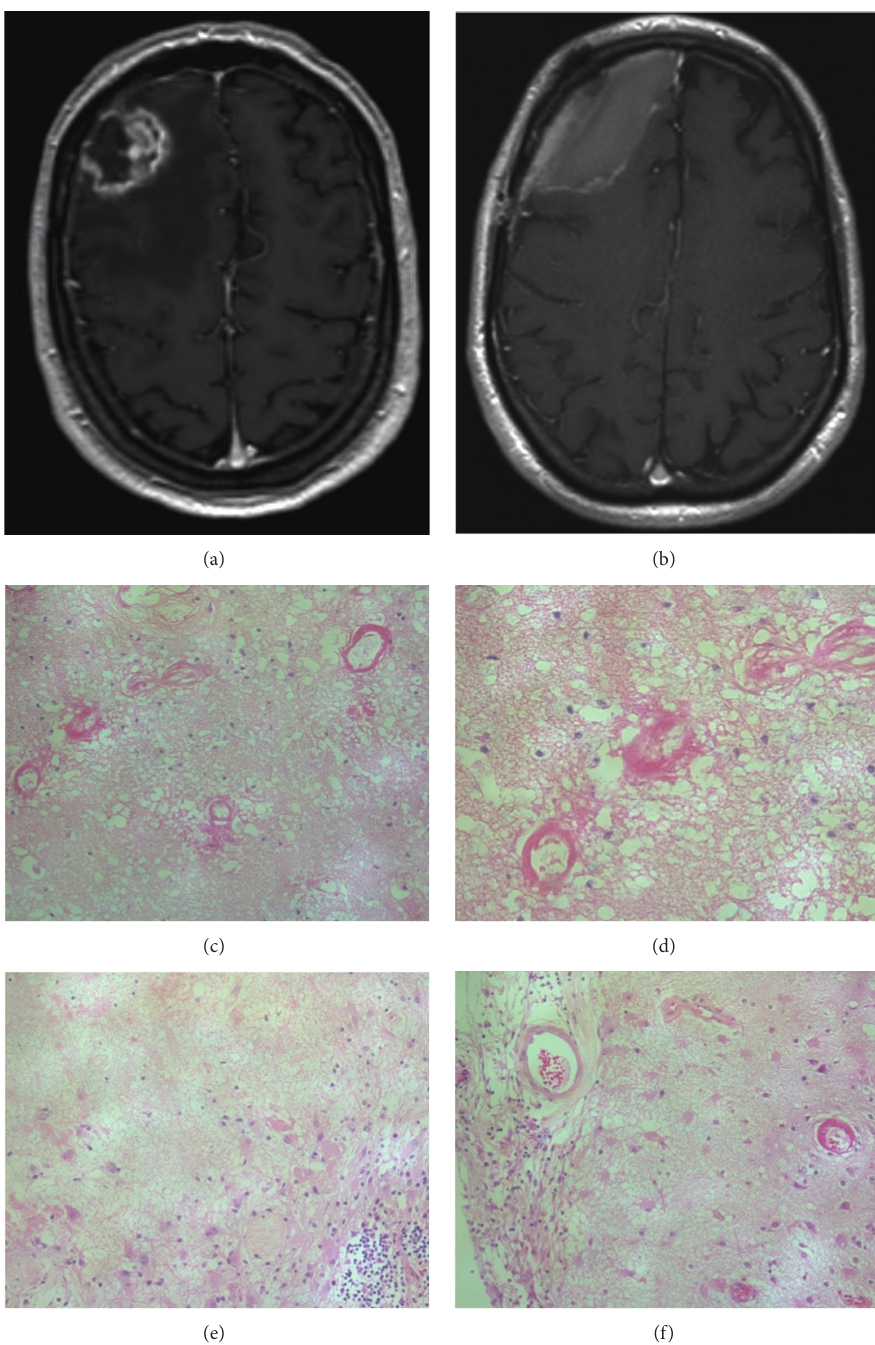
Figure 2: Gadolinium-enhanced T1-weighted MRI images obtained (a) 2 months after initiation of corticosteroids and (b) after surgical resections.Histopathologicalexaminationindicating(c)tissuenecrosisandfibrinoidnecrosisofsmallbloodvessels(HematoxylinandEosine (H&E) staining, × 200); (d) H&E staining ( × 400); (e) radionecrosis surrounding gliosis and inflammatory cell reaction (H&E staining, × 200); and (f) focal infiltration of inflammatory cells and subpial gliosis (H&E, staining ×